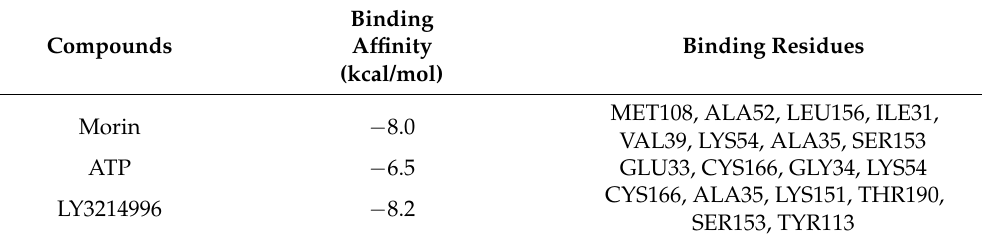
Figure 7. In silico molecular docking analysis showed binding between ERK2 and morin, LY3214996, or ATP. ( A ) 2D diagrams showing the types of contacts formed between ERK2 and the indicated ligands. The colors of dotted lines represent types of interactions between ERK2 binding site residues and the indicated ligands. ( B ) 3D interactions showing the binding pocket structure of ERK2 and the indicated ligands. Table 2. Binding affinities and binding residues as determined by molecular